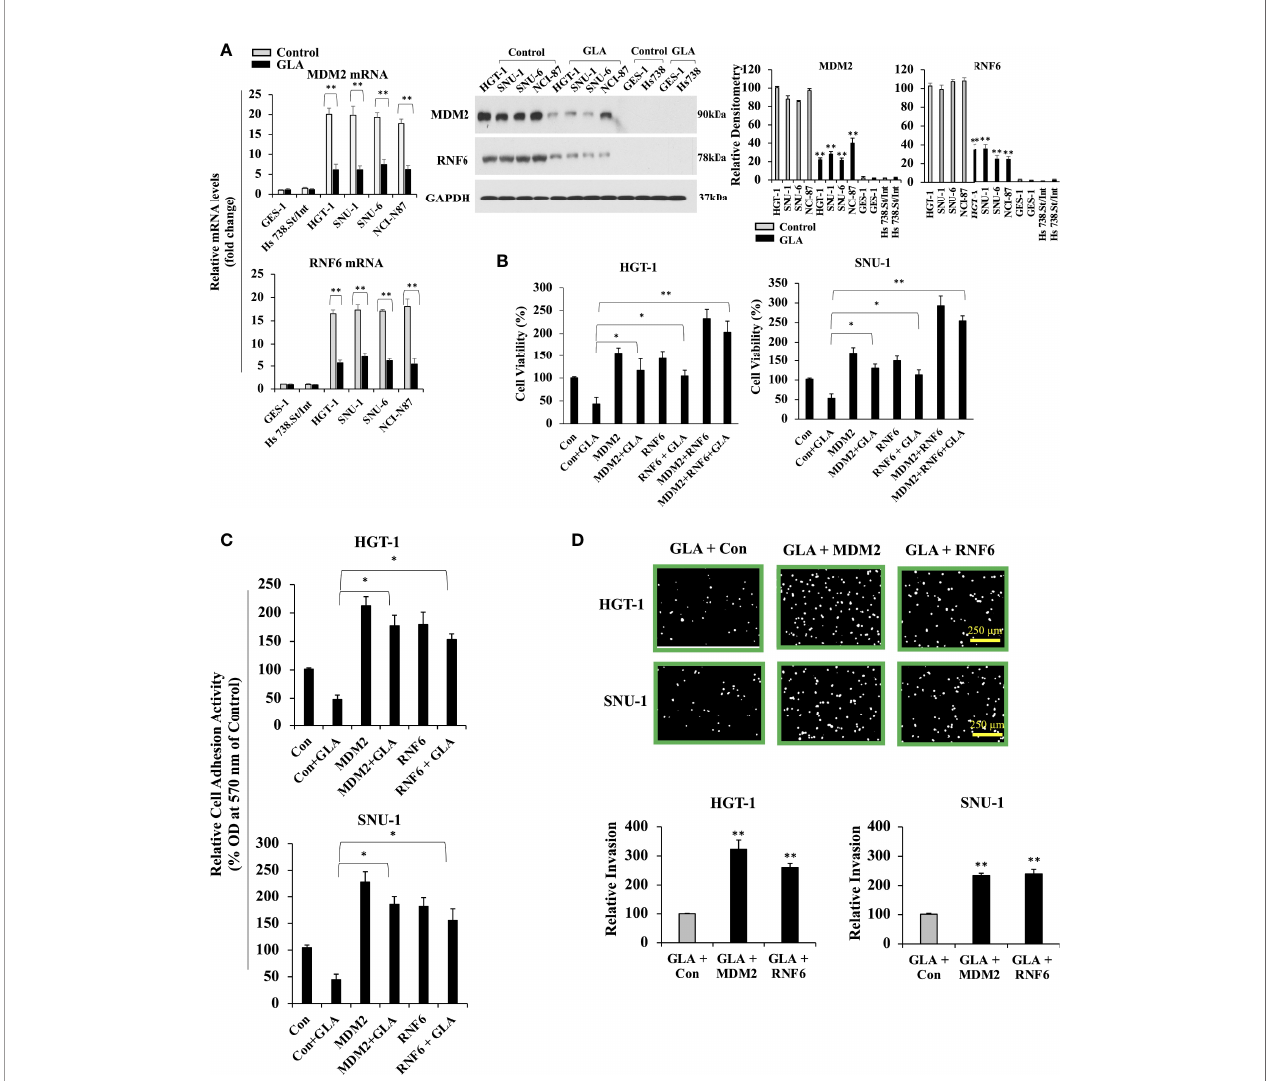
FIGURE 2 | Inhibition of MDM2 and RNF6 in GC cells by GLA. (A) Fold change in mRNA levels of MDM2 and RNF6 examined by real-time RT-PCR in GES-1, Hs 738. St/Int, HGT-1, SNU-1, SNU-6, and NCI-N87 cells with the treatment of 10 µM of GLA (left panel). Western blot analysis of MDM2 and RNF6 in the indicated GC cells treated with GLA (right panel). (B) Changes in cell viability of HGT-1 and SNU-1 cells with restored overexpression of MDM2 or RNF6 in the presence of 10 µM of GLA for 48 h. (C) Cell adhesion activity and invasion (100 × magni fi cation; scale bar-250 µm) (D) of HGT-1 and SNU-1 cells with restored overexpression of MDM2 or RNF6 in the presence of 10 µM of GLA for 12 h. The Western blot analysis was repeated three times. The data represented the mean ± SD (n=3). * p < 0.05, ** p < 0.01 vs